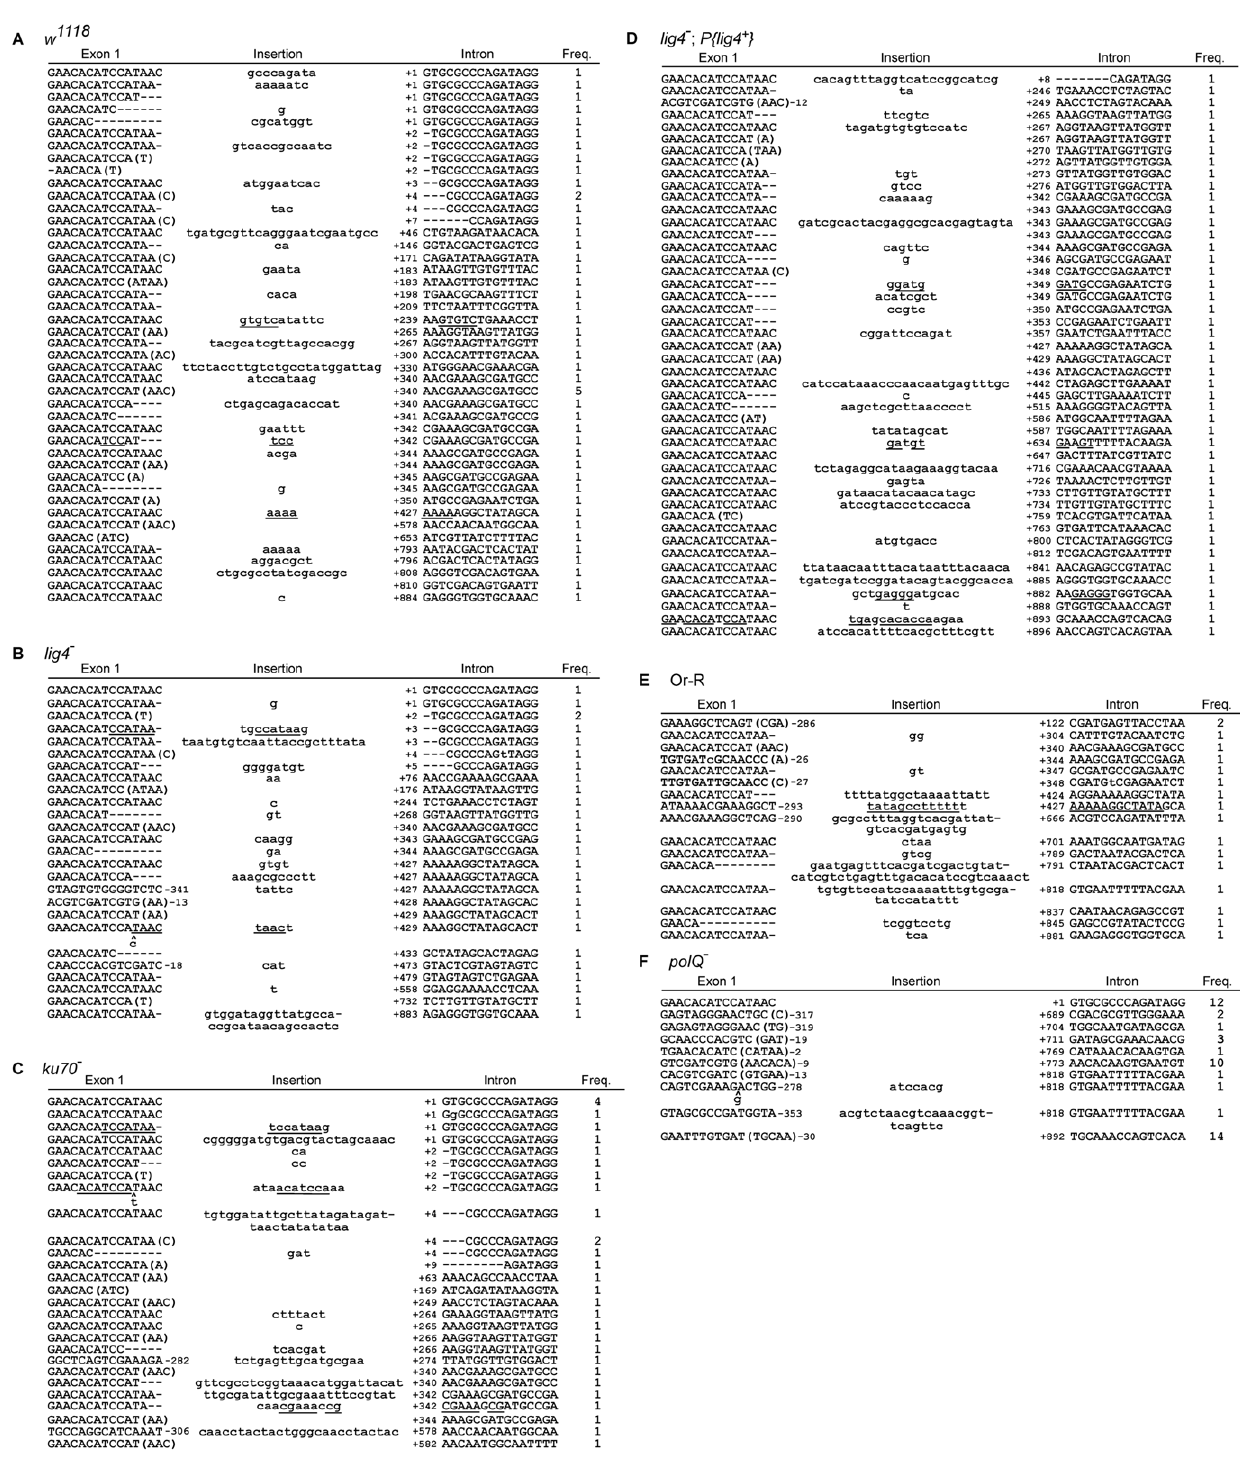
Figure 4. Sequences of 5 9 -integration junctions from linear intron RNA retrohoming in wild-type and mutant strains. 5 9 -integration junctions of DNA extracted from 80 pooled embryos for each strain were amplified by PCR, as described in Figure 3, then TOPA-TA cloned, amplified by colony PCR, and sequenced, as described in Materials and Methods. (A) wild-type w 1118 ; (B) lig4 2 ; (C) ku70 2 ; (D) lig4 2 ; P{lig4 + }; (E) wild-type Or-R; (F) polQ 2 . Inserted or mutant nucleotide residues are shown in lower case letters; microhomologies between intron and exon end sequences prior to ligation are shown in parentheses; and inserted sequences that match or are complementary to nearby 5 9 -exon or intron sequences are underlined. Freq., frequency of occurrence.